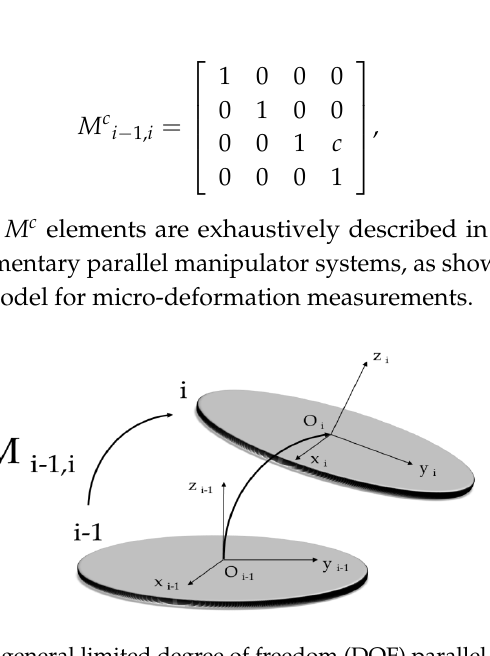
Figure 3. Homogeneous Transformation Matrix system composition of subsequent reference plane.